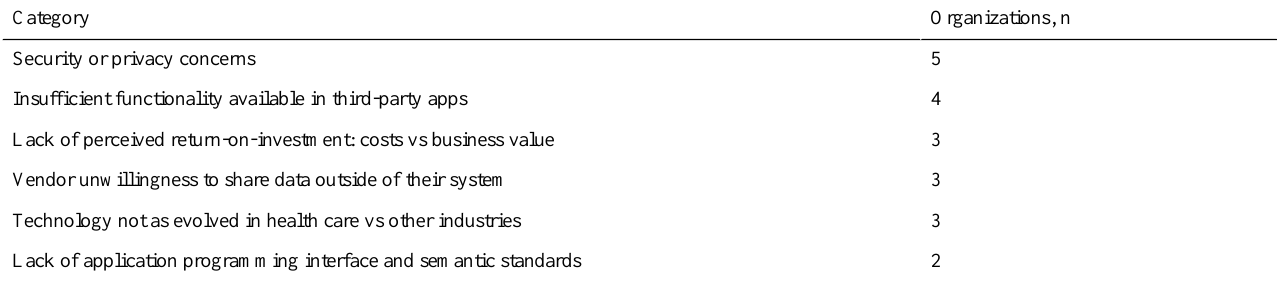
Table 4. Perceived barriers to the current/future implementation/use of patient-facing application programming